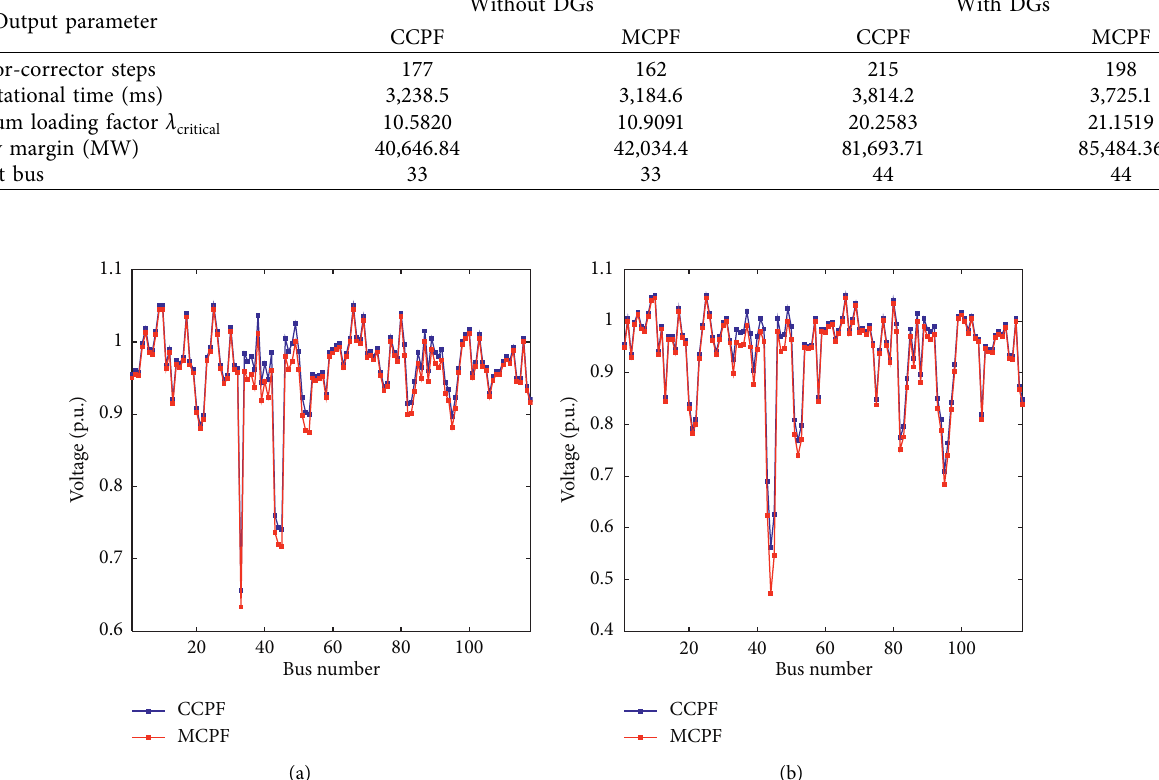
Figure 13: Voltage profile of 118 buses: (a) without the integration of DGs and (b) with the integration of